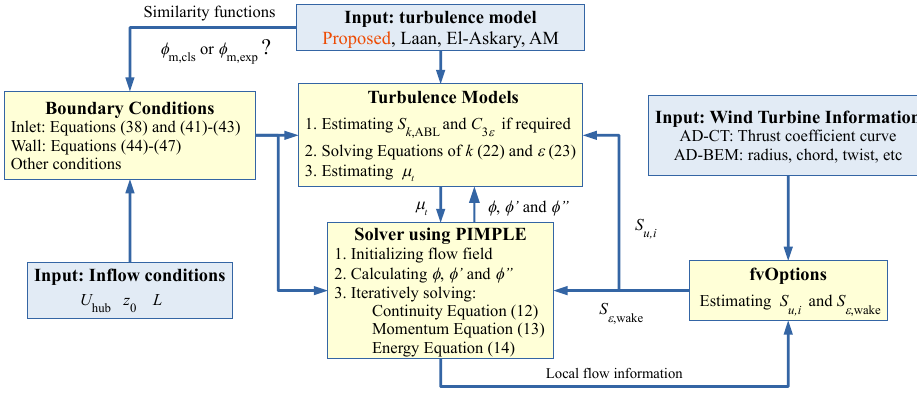
Figure 11. Implementations of wake models in OpenFOAM where φ (cid:48) = ∂φ / ∂ζ , φ (cid:48)(cid:48) = ∂ 2 φ / ∂ζ 2 for φ ∈ { φ k , φ m , φ ε }